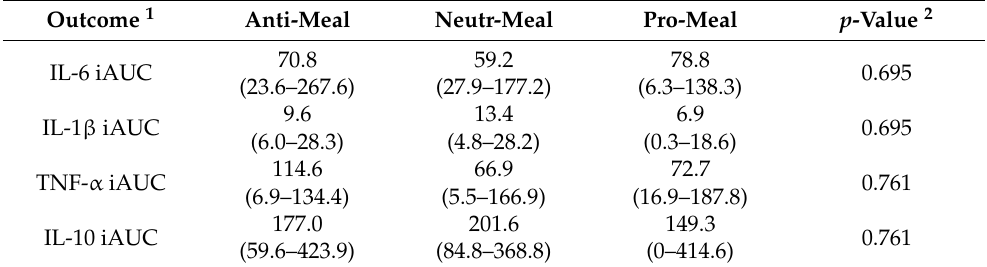
Table 5. Postprandial plasma glucose, insulin, and serum lipid measures for Anti-meal, Neutr-meal and Pro-meal.